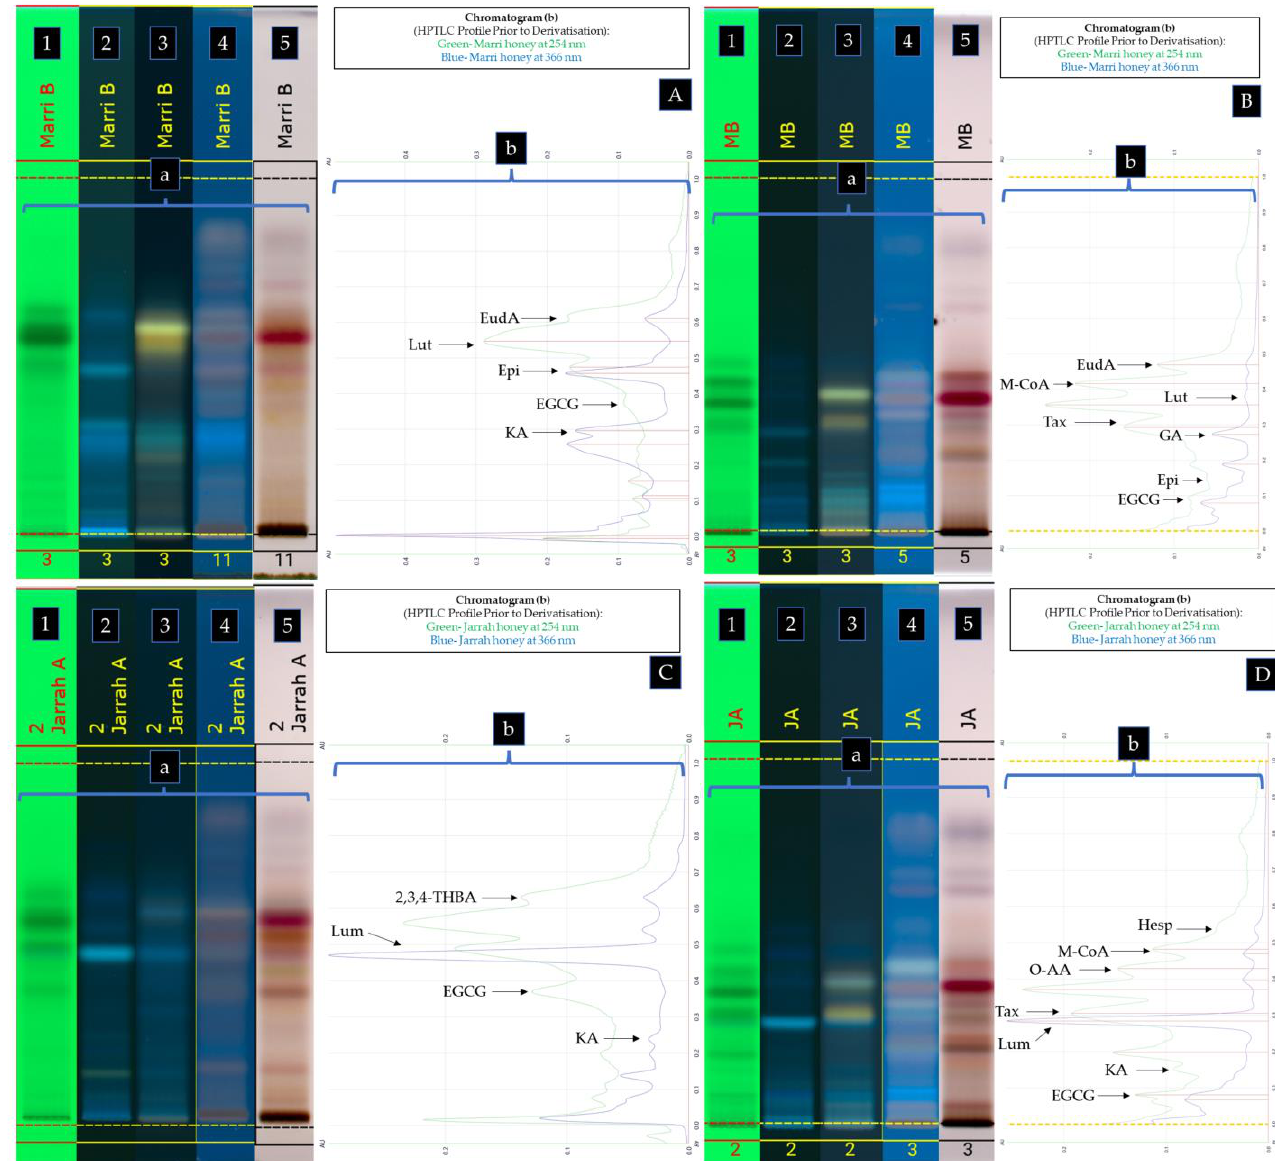
Figure 6. HPTLC Profile of Corymbia calophylla (Marri) honey ( A , B ) and Eucalyptus marginata (Jarrah) honey ( C , D ) using mobile phase A ( A , C ), and mobile phase B ( B , D ). Plate images ( a ) obtained under the following light conditions: 254 nm prior to derivatisation ( 1 ), 366 nm prior to derivatisation ( 2 ), 366 nm after derivatised with NP-PEG ( 3 ), 366 nm after derivatisation with VSA ( 4 ), transmittance in white light after derivatisation with VSA ( 5 ) and chromatograms ( b ) prior to derivatisation obtained at 254 nm and 366 nm.